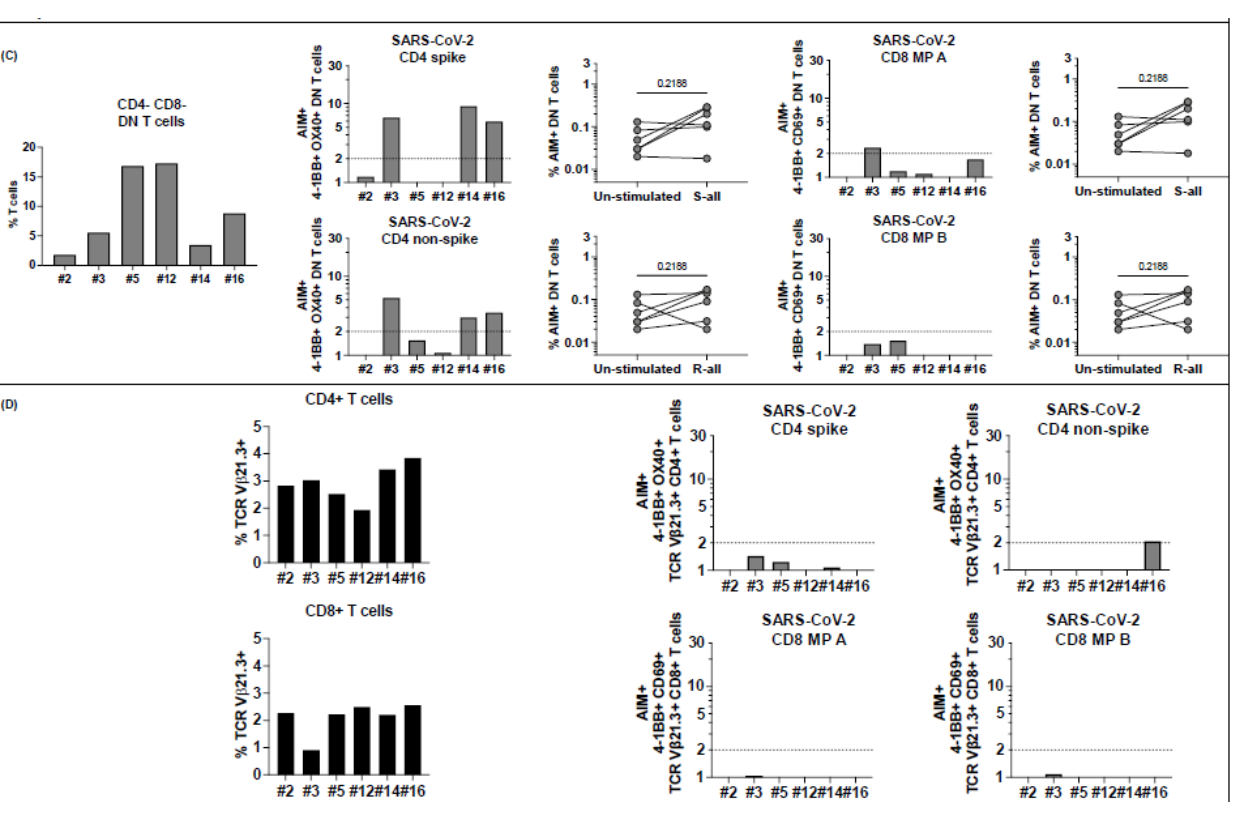
Figure 6. T cell responses to peptide megapools derived from SARS-CoV-2 in MIS-C subjects healthy 6-14 months after the disease onset. Six MIS-C subjects (2, 3, 5, 12, 14, and 16) studied at their subacute phase were also studied 6–14 months later. Canonical CD4+ and CD8+, CD4 − CD8 − DN, and TCR V β 21.3+ CD4+ and CD8+ T cell responses to SARS-CoV-2 peptide megapools were studied. The SI of AIM+ T cells from each individual subject was calculated to study the T cell responses. ( A ) CD4+ and CD8+ T cell responses to peptide megapools and their CCR6 expressions. Three subjects (2, 3, and 5) of the 6 subjects showed concurrent CD4+ and CD8+ T cell responses, and the other 3 follow-up MIS-C subjects (12, 14, and 16) showed only CD4+ T cell responses to SARS-CoV-2 (both CD4 spike (S) and nonspike (R) megapools). ( B ) Memory phenotypes of AIM+ CD4+ (left panels) and CD8+ (right panels) T cells. Red circles: subjects responding to both CD4 and CD8 epitopes (subjects 2, 3, and 5); blue circles: subjects responding to both CD4 spike and nonspike epitopes (subjects 12, 14, and 16). AIM+ CD4+ T cells showed a similar level of TEMRA, TEM, and TCM at follow-up visit compared with subacute MIS-C subjects ( p > 0.05). AIM+ CD8+ T cells showed a slight increase in TEM ( p > 0.05) and a similar level of TEMRA and TCM. ( C ) Percentage of DN T cells (left panel) and their responses to SARS-CoV-2 peptide megapools (right panels). Percentages of DN T cells were decreased in 5 subjects (2, 3, 5, 12, and 14) compared with subacute MIS-C subjects. One subject (3) showed DN T cell responses to SARS-CoV-2 CD4 and CD8 peptide megapools, and 2 subjects (14 and 16) showed DN T cell responses to SARS-CoV-2 CD4 spike and nonspike peptide megapools. ( D ) Percentage of CD4+ and CD8+ TcR V β 21.3 (black bars, left panels). An amount of 2.0%–3.9% of CD4+ T cells and 0.9%–2.6% of CD8+ T cells were TCR V β 21.3+ among the 6 subjects studied. TCR V β 21.3+ CD4+ T cells in 1 subject (16) showed a minor response to a SARS-CoV-2 CD4 nonspike peptide megapool. Each symbol represents an individual subject. Comparisons of the percentage of AIM+ T cells between unstimulated control and peptide megapool-stimulated cell cultures were tested by the Wilcoxon signed-rank test. Comparisons of the memory phenotypes of AIM+ T cells between subacute and follow-up visit were tested by the Mann–Whitney U test.